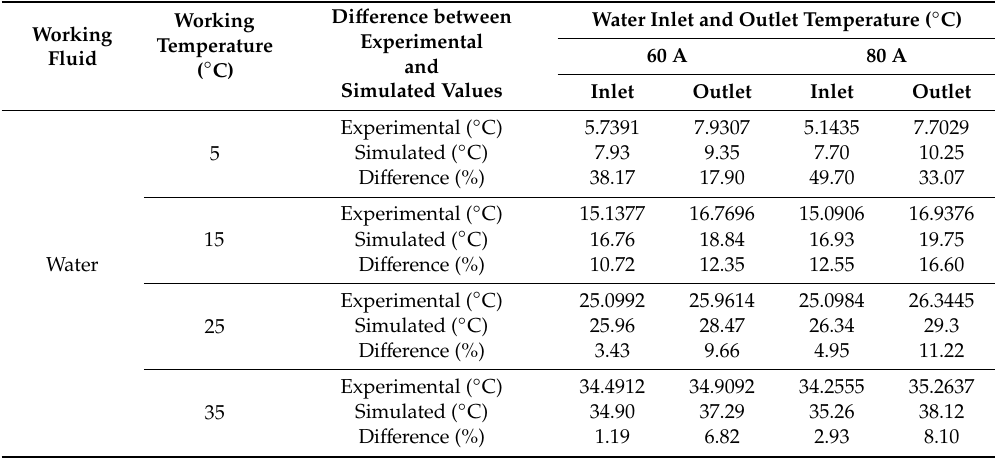
Table 3. Water inlet and outlet temperature at 60 A and 80 A with di ff erent working